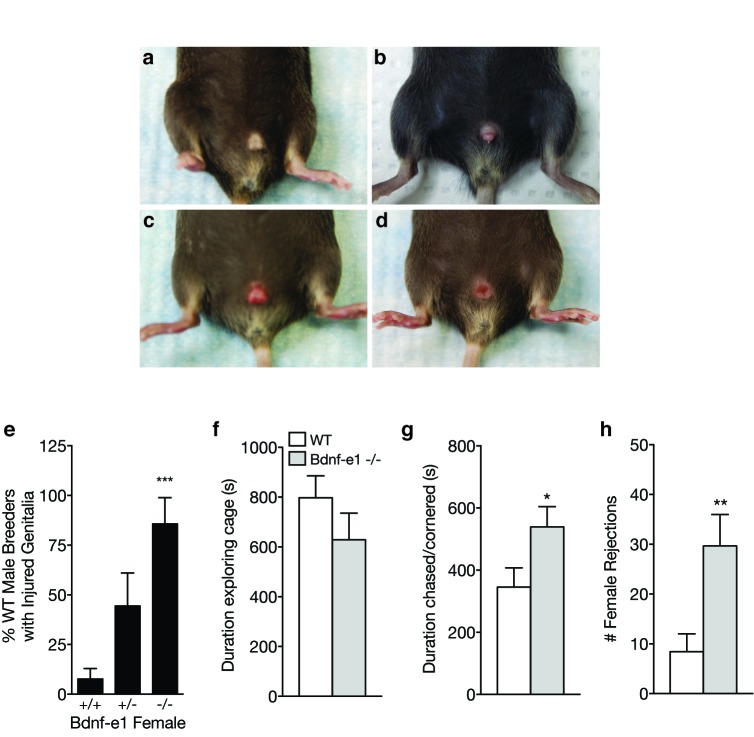
Bdnf-e1 -/- females show abnormal mating behaviors.(a-d) Representative images depicting male genitalia injuries observed in Bdnf-e1 breeder cages. Breeder males frequently show inflamed, infected, and/or mutilated genitalia (b–d) compared to normal (a) when paired with heterozygous or homozygous Bdnf-e1 females. (e) Bar graph depicting the percentage of WT male breeders with injured genitalia when paired with females that are wild-type, heterozygous, or homozygous for promoter I-derived BDNF production. WT males rarely show injuries when paired with WT females; however, partial or complete loss of promoter I-derived BDNF leads to significant increases in injured males (1-way ANOVA; n = 26 + /+, n = 9 + /-, n = 7 -/-; p<0.001). (f–h) Quantification of mating behaviors between WT (n = 12) or Bdnf-e1 -/- (n = 12) estrous females and CD1 males, including duration exploring (f) duration chased/cornered (g) and number of female rejections (h). WT and Bdnf-e1 -/- females spend equal time exploring; however, Bdnf-e1 -/- females are more frequently cornered or chased by males (Student’s t test, p<0.05). Bdnf-e1 -/- females also show a significant increase in mounting rejections (Student’s t test, p<0.01). Data are means ± SEM; *p<0.05, **p<0.01.